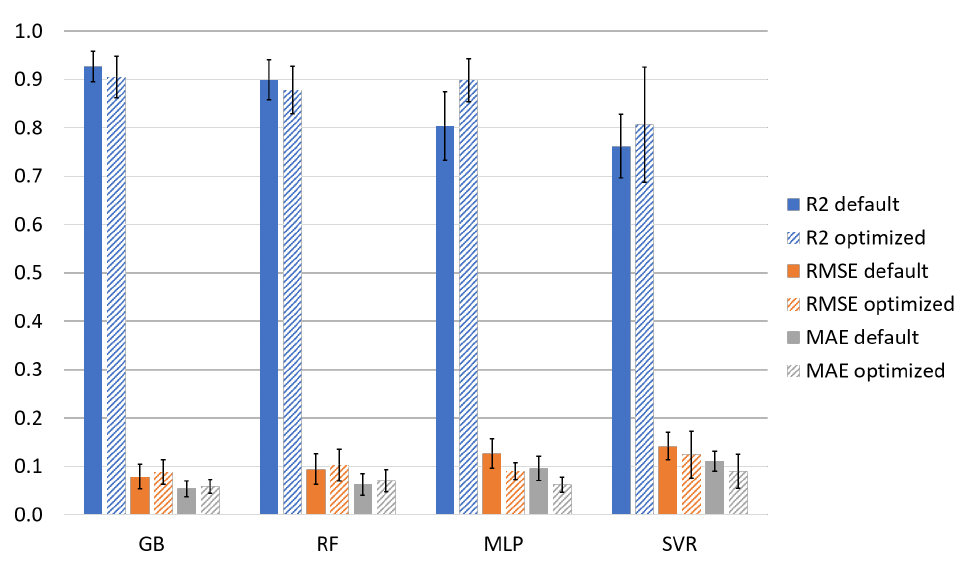
Figure 12. Comparison of test performances of GB, RF, MLP and SVR with default vs. optimized